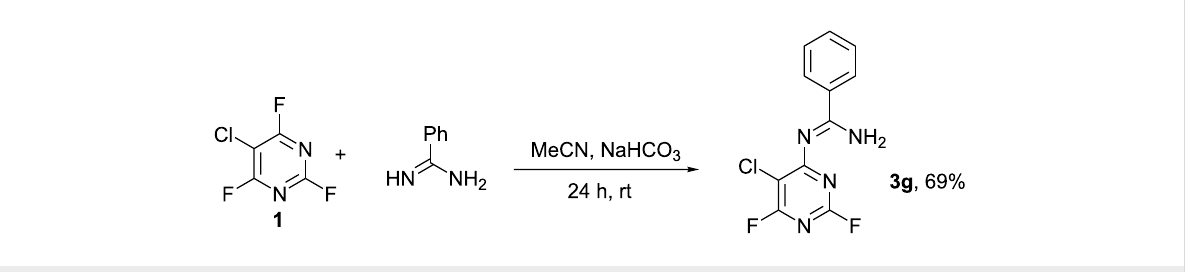
Scheme 2: Reaction of 1 with benzamidine.